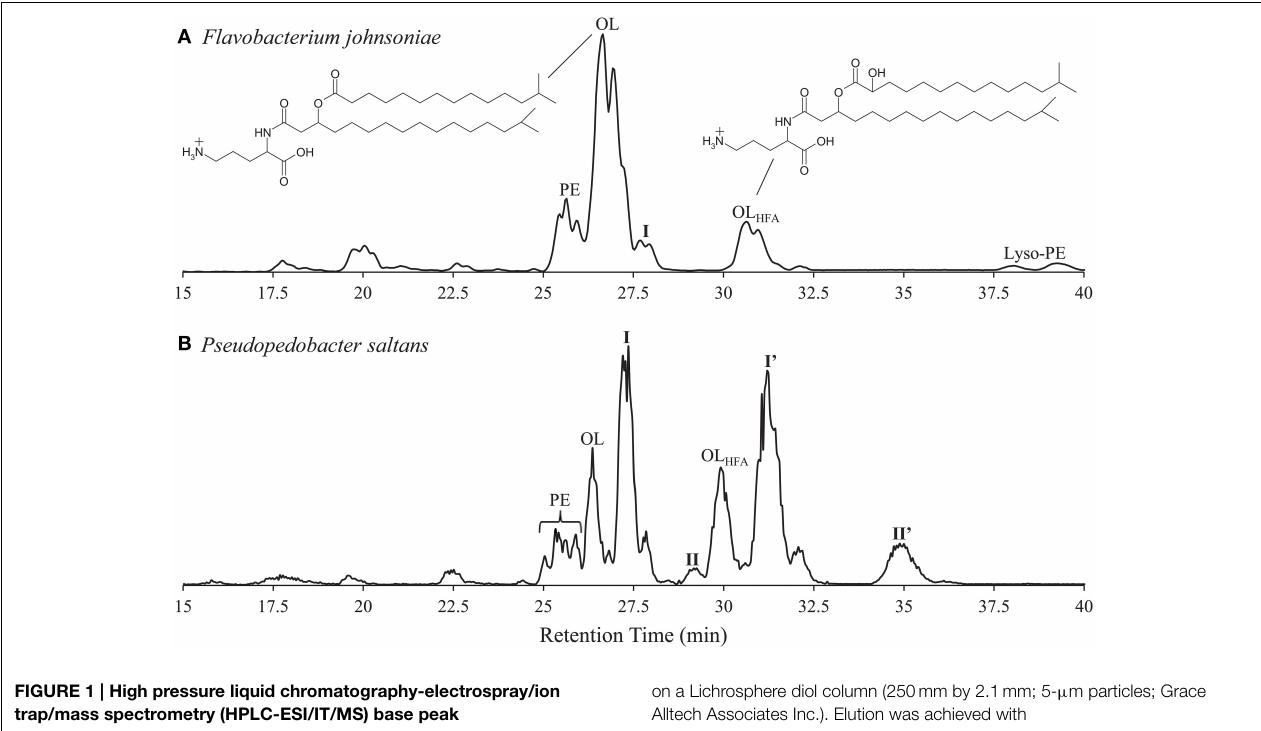
on a Lichrosphere diol column (250mm by 2.1mm; 5- µ m particles; Grace Alltech Associates Inc.). Elution was achieved with hexane–2-propanol–formic acid–14.8M aqueous NH 3 (79:20:0.12:0.04, v/v/v/v) (A) and 2-propanol–water–formic acid–14.8M aqueous NH 3 (88:10:0.12:0.04, v/v/v/v) (B) starting at 10% B, followed by a linear increase to 30% B in 10min, followed by a 20-min hold and a further increase to